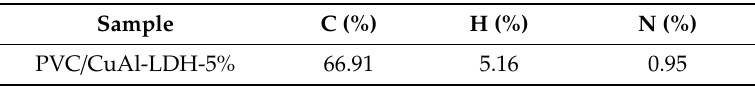
Table 4. Element analysis of the carbonized product.